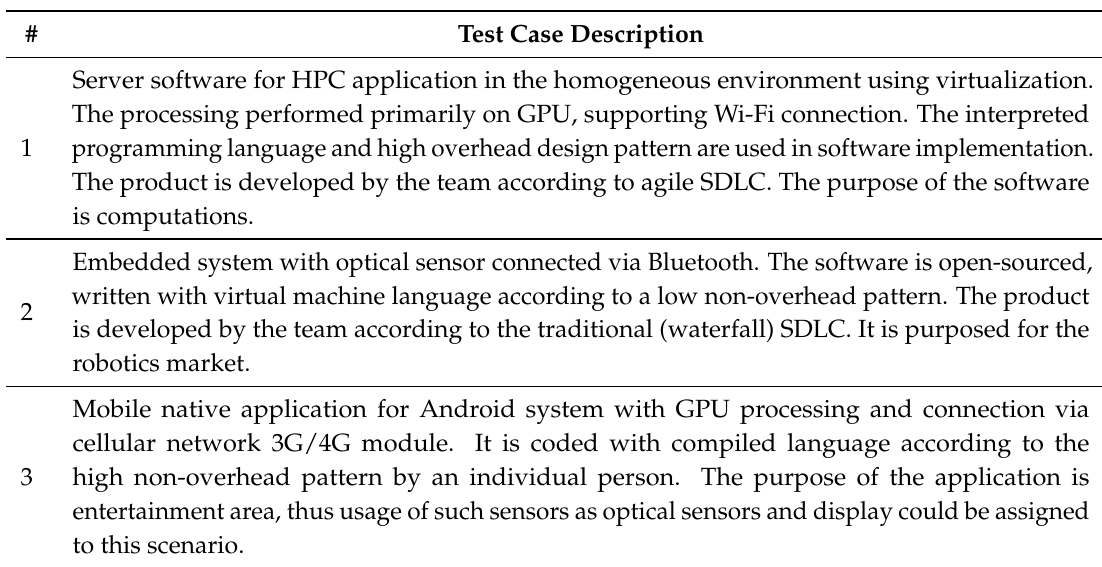
Table 2. Test cases for embedded, mobile and desktop